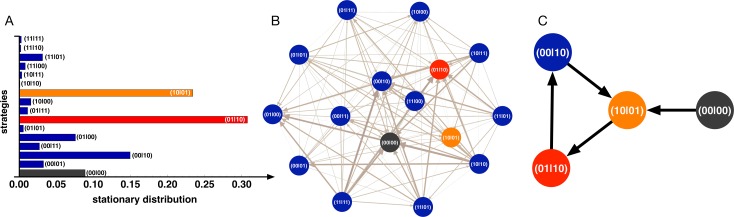
Dynamics.
A) The bar plot shows the fraction of time the population spends in each monomorphic configuration of every strategy (σα σβ | A0 A1) (see main text for details). B) The graph represents all strategies, one at each node, with edges representing transitions between strategies above neutral drift. For the parameter values chosen (Z = 100, N = 9, M = 5, c = 0.3, c
s = 0.06, γ = 0.5, F = 10, λ = 0.8), no strategy is Evolutionary Robust (ERS). C) We show the graph resulting from studying the dynamics in the subspace of strategies including the 4 most abundant in A, highlighting a 3 strategy loop which often occurs for large values of λ. When the state of Nature α occurs more often than β (here λ = 0.8), (10|01) can be invaded by its complementary discriminative strategy—(01|10)—benefiting from cheaper signals to achieve the same goal of coordinating collective action. (01|10), in turn, can be invaded by (00|10), thus saving the cost of signaling under B. This, in turn, can be invaded again by (10|01) closing a loop in probability space that precludes the emergence of any ERS. Note further, that despite not being the most prevalent strategy, (10|01) plays a crucial role, as it is the only one of those strategies in the loop that can invade (00|00).